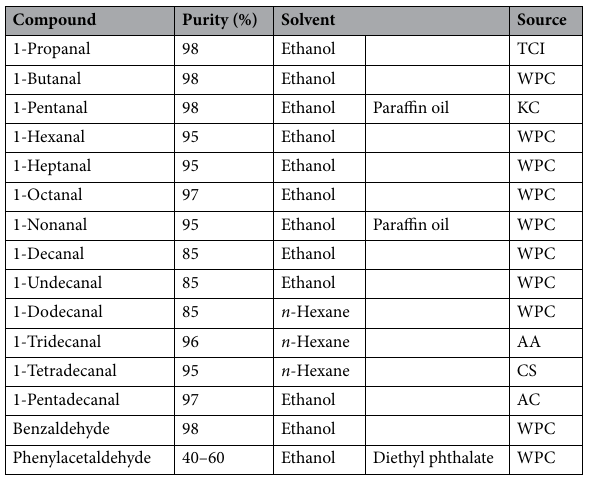
Table 2. Compounds used for analyzing responses to aldehyde. AA Alfa Aesar, AC Angene Chemical, CS ChemSampCo, KC Kanto Chemical, TCI Tokyo Chemical Industry, WPC Wako Pure